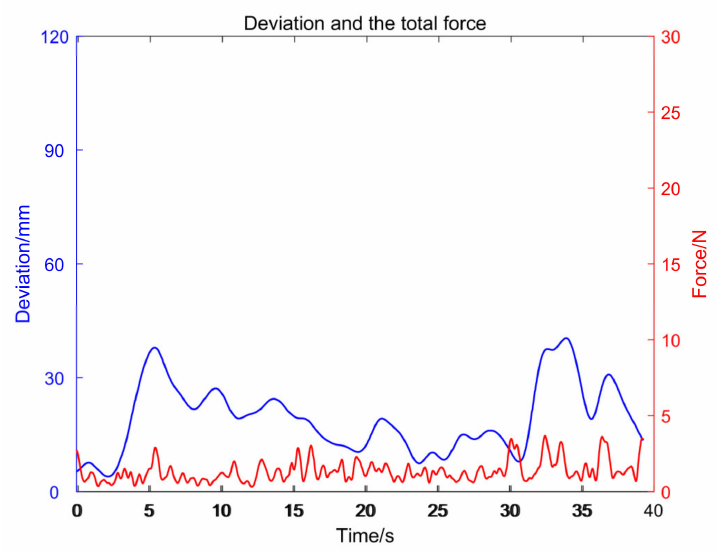
Figure 19. The total interaction force and the deviation between the handle and the subject’s